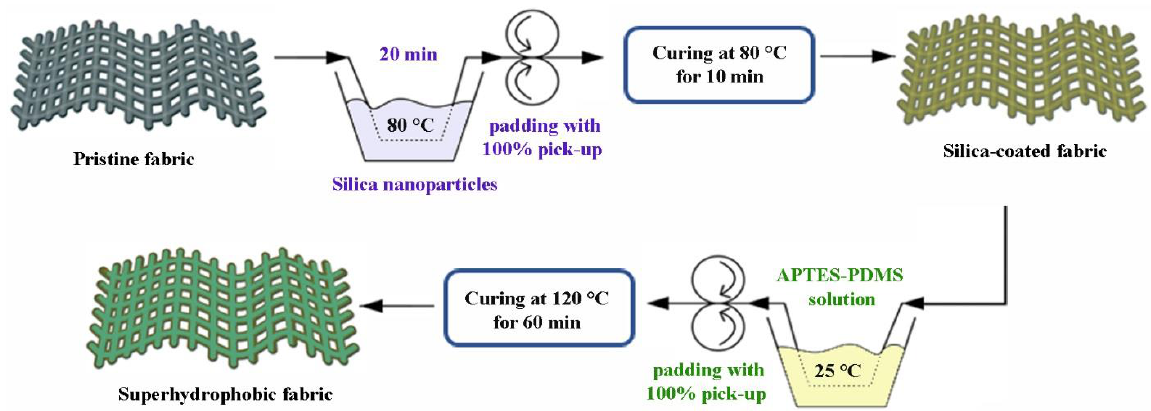
Figure 1. Schematic representation of fabric superhydrophobic coating.